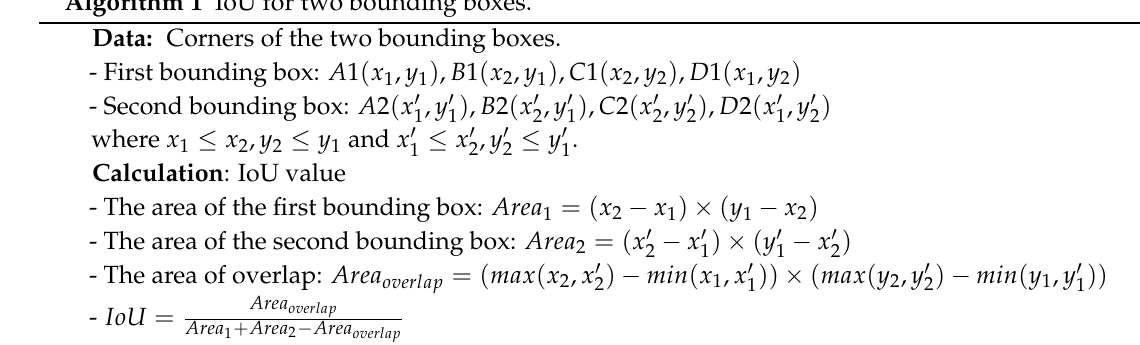
Algorithm 1 IoU for two bounding